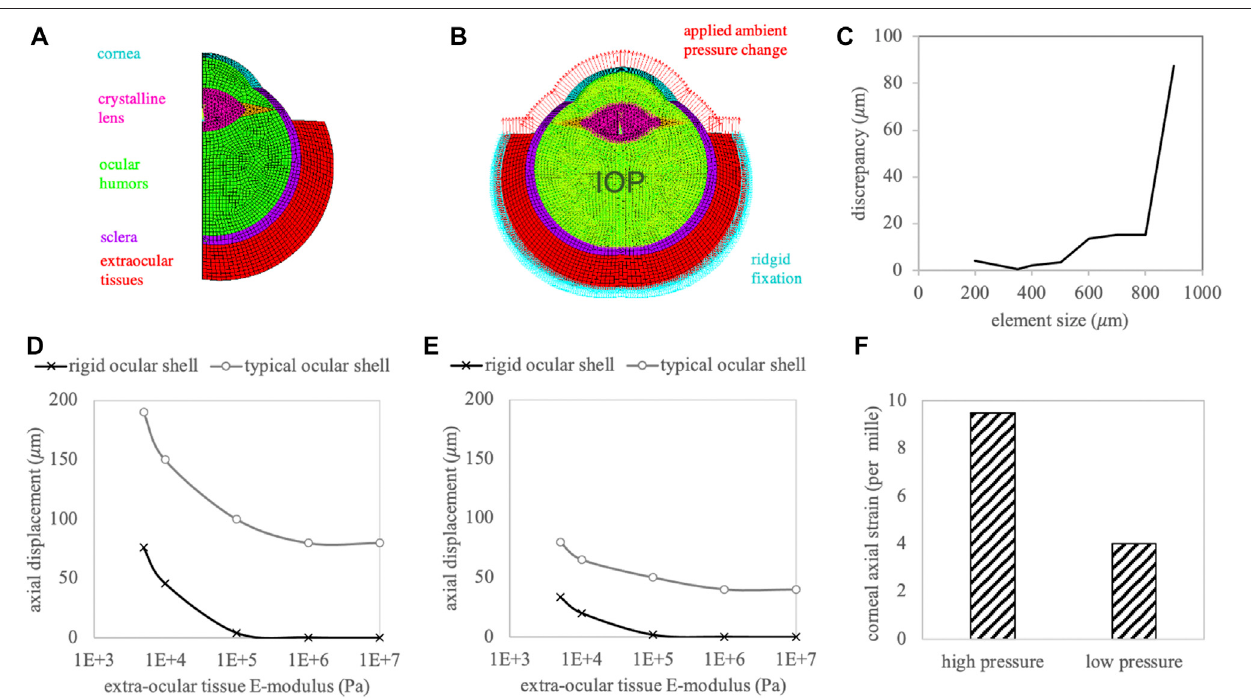
FIGURE5|(A) Meshedandlabelledgeometryofthe fi niteelementsimulation. (B) Appliedboundaryconditions.Redarrowsrepresenttheactuationoftheambient pressure modulation. (C) Mesh size evaluation. Resulting axial corneal displacement with (D) high and (E) low ambient pressure modulation. (F) Axial corneal strain